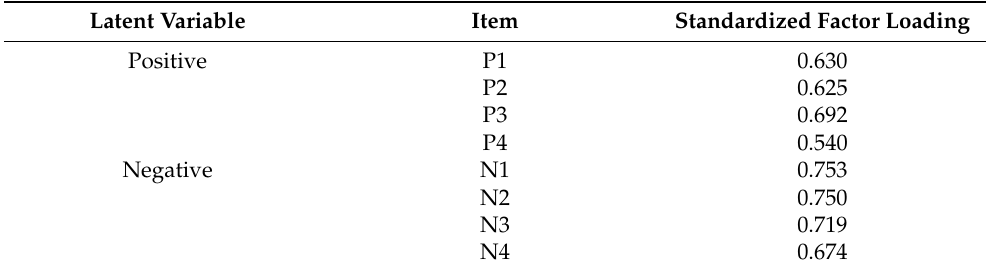
Table 7. Factor loadings.